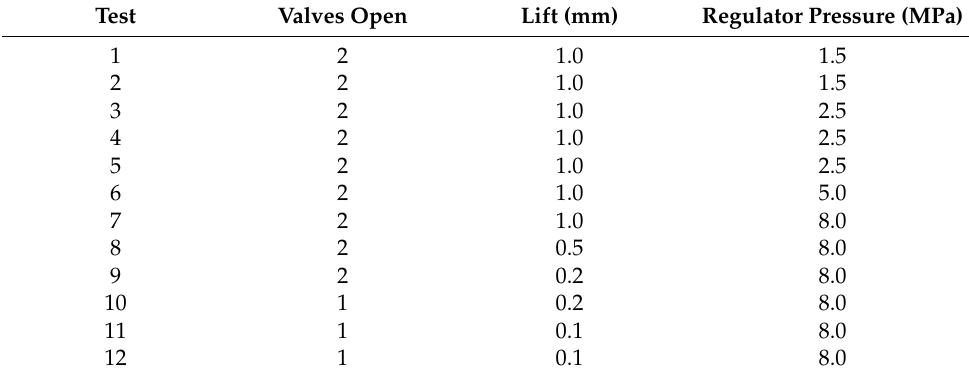
Table 2. AMRC flow rig test